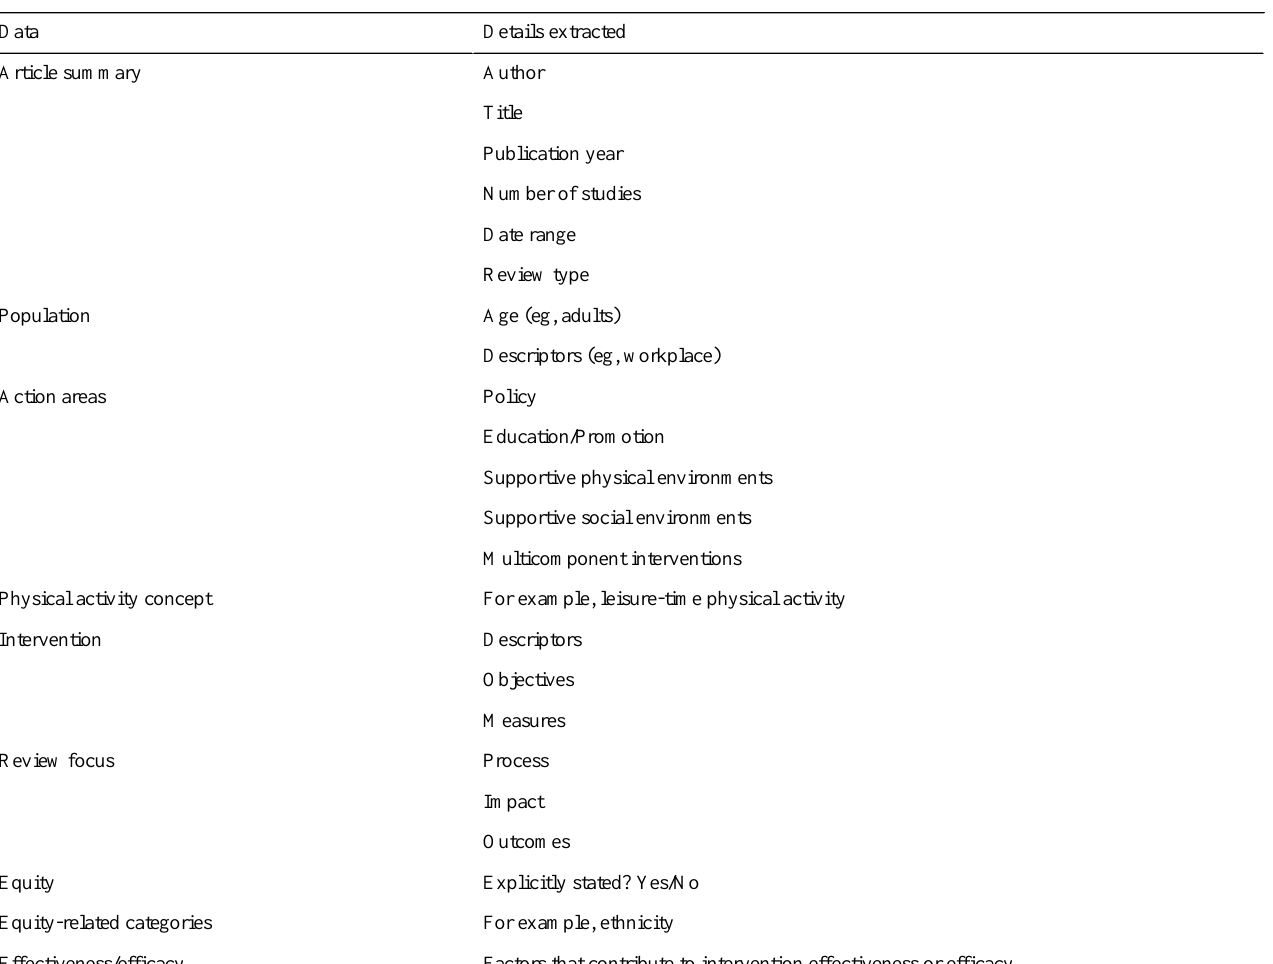
Table 1. Data-extraction tool.